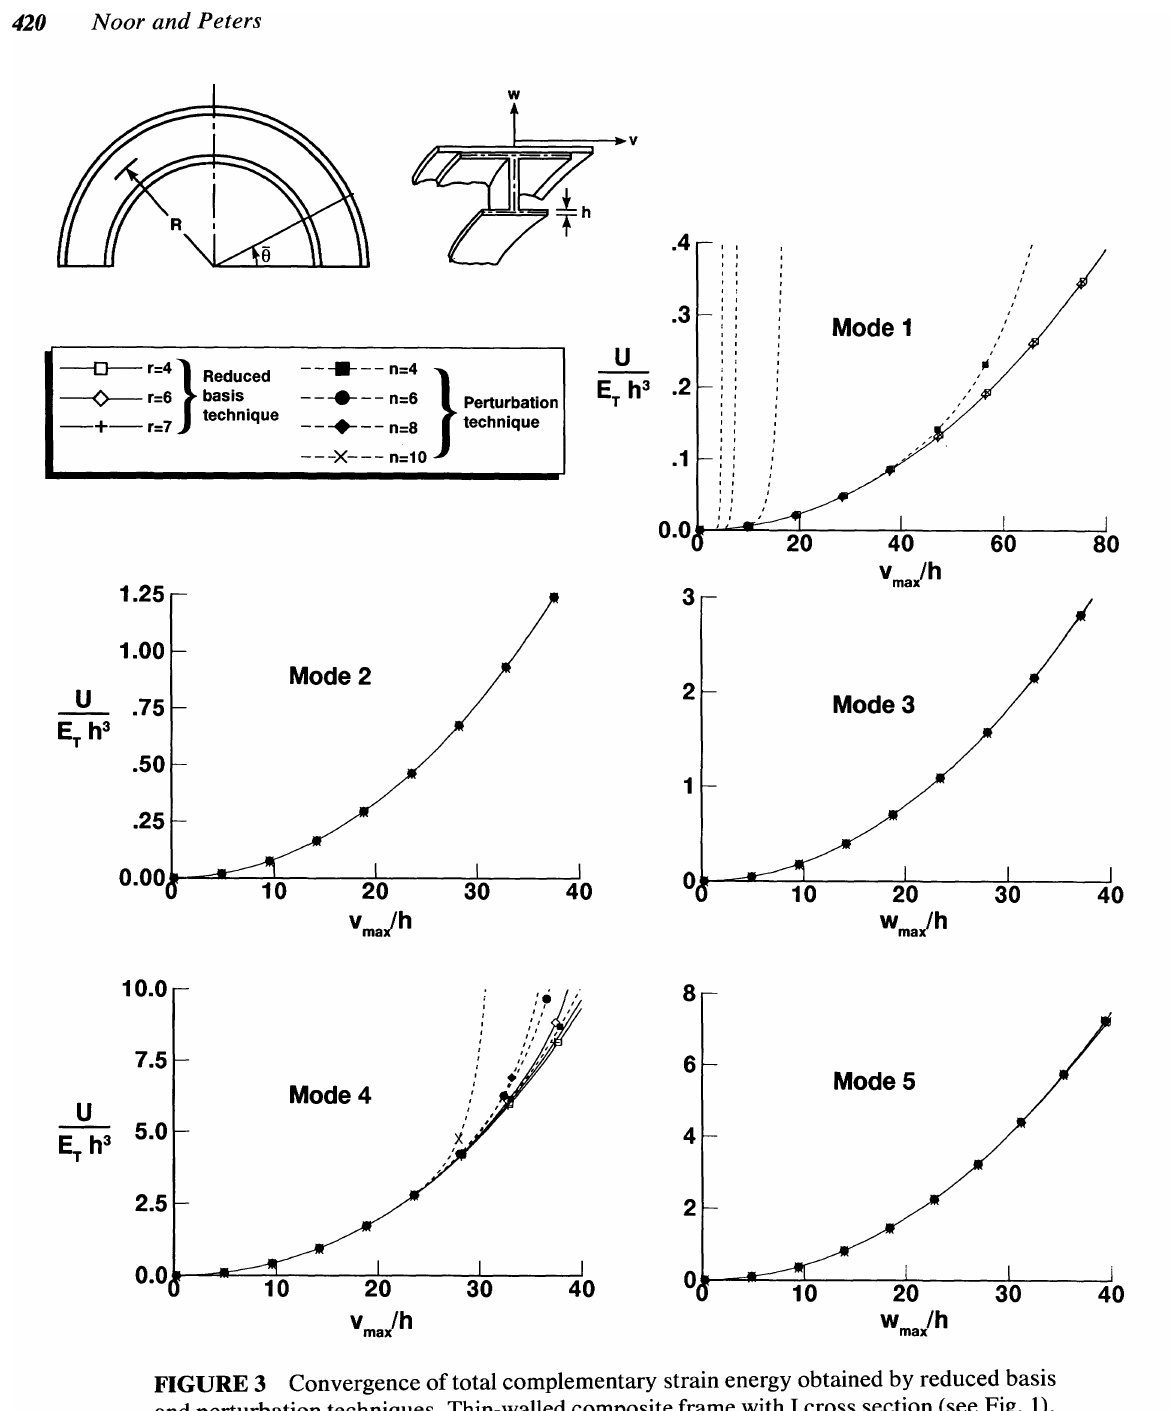
FIGURE 3 Convergence of total complementary strain energy obtained by reduced basis and perturbation techniques. Thin-walled composite frame with I cross section (see Fig.